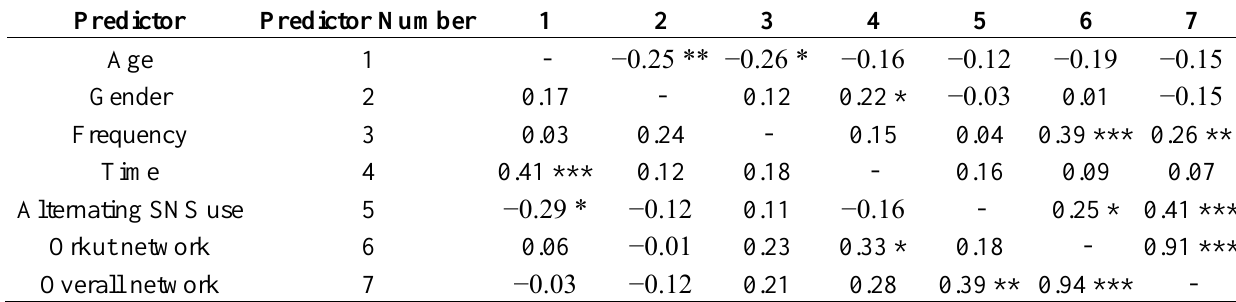
Table 7. Intercorrelations for predictors and logged Orkut network size and logged overall network size. Upper half matrix refers to non-migrant users; lower half matrix to migrant users.